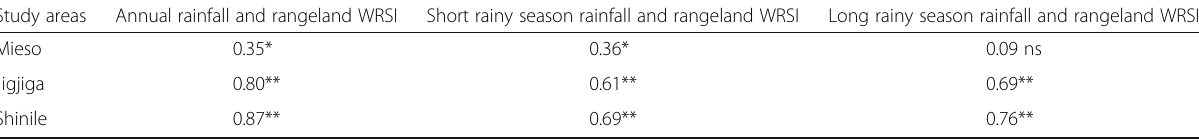
Table 2 Coefficient of regression for annual rainfall and seasonal rainfall (predictors) and rangeland WRSI values (dependent variable) for the period 1984 – 2015 in Mieso, Jigjiga, and Shinile districts of eastern Ethiopia Study